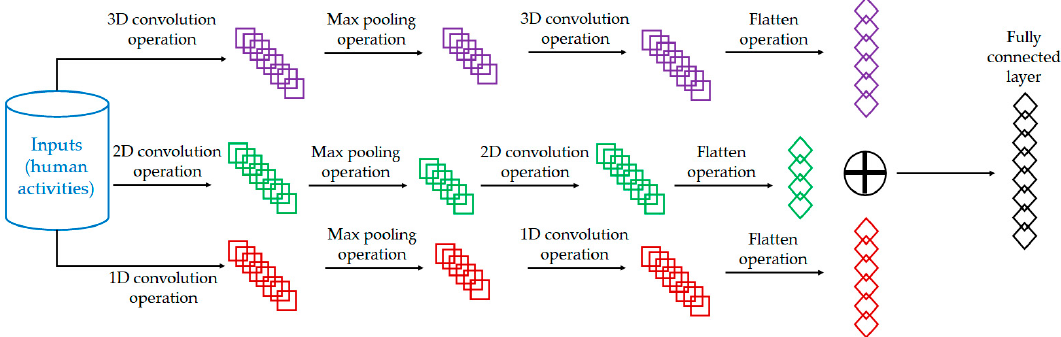
Figure 1. The architecture of the 3D-2D-1D-CNN algorithm for feature extraction.